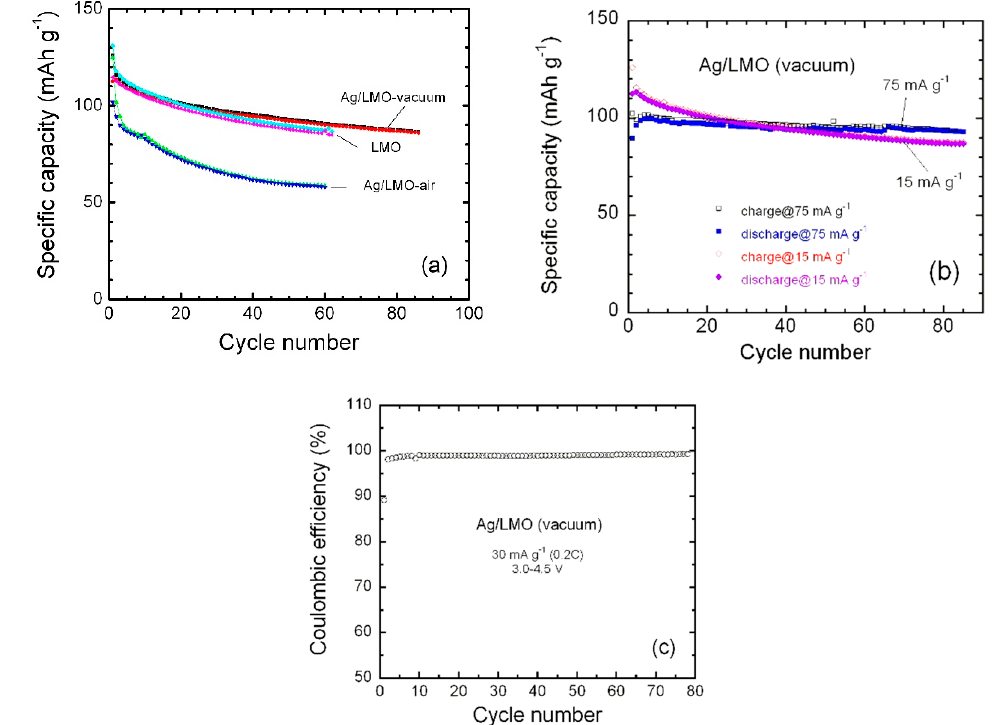
Figure 13. ( a ) Cyclability of pristine LMO, Ag/LMO(v) and Ag/LMO(a) electrodes tested within the voltage range 3.0–4.5 V at C/10 rate; ( b ) cyclability of pristine LMO Ag/LMO(v) tested at C/10 and C/2 rate; and ( c ) Coulombic efficiency of the Ag/LMO(v) electrode.